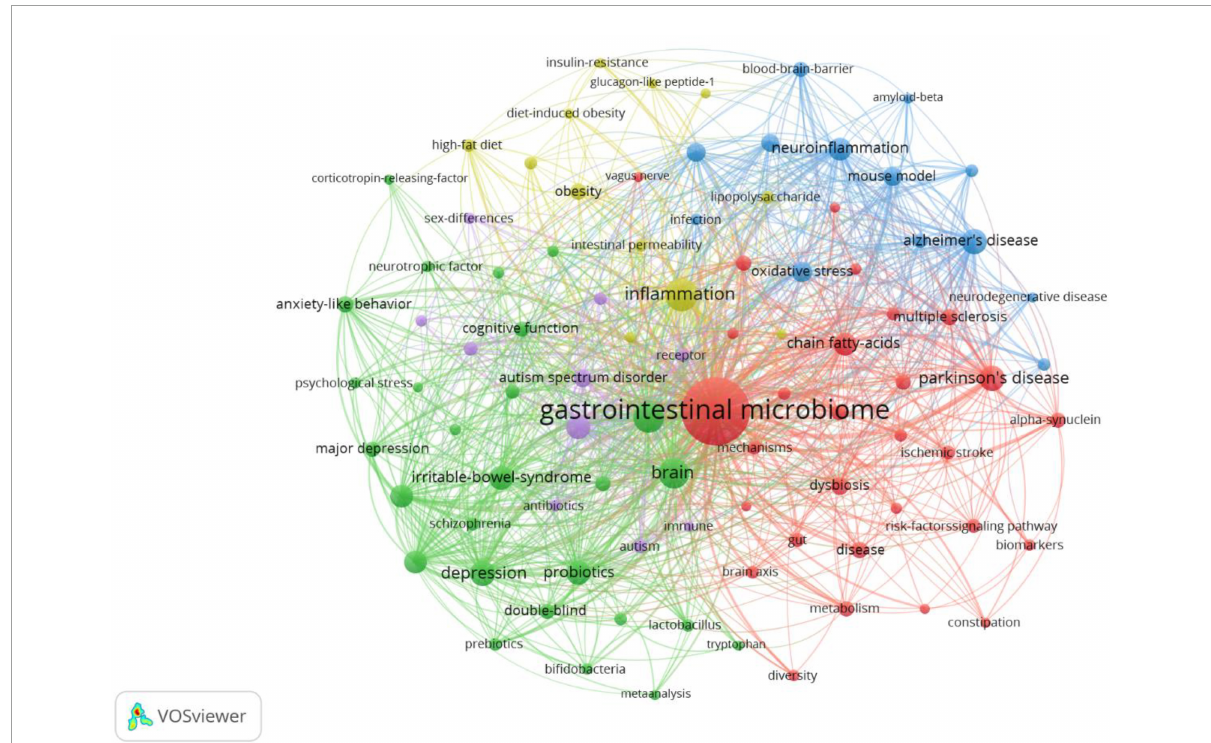
FIGURE6 Co-occurrence and clustering of keywords in title/abstract fields of publications related to gastrointestinal microbiome and neuroscience. Map of keywords clustering showed 91 keywords with a minimum of 40 occurrences and divided into five clusters. Notes: The size of node and word reflects the co-occurrence frequencies, the link indicates the co-occurrence relationship, and nodes with the same color denote the same